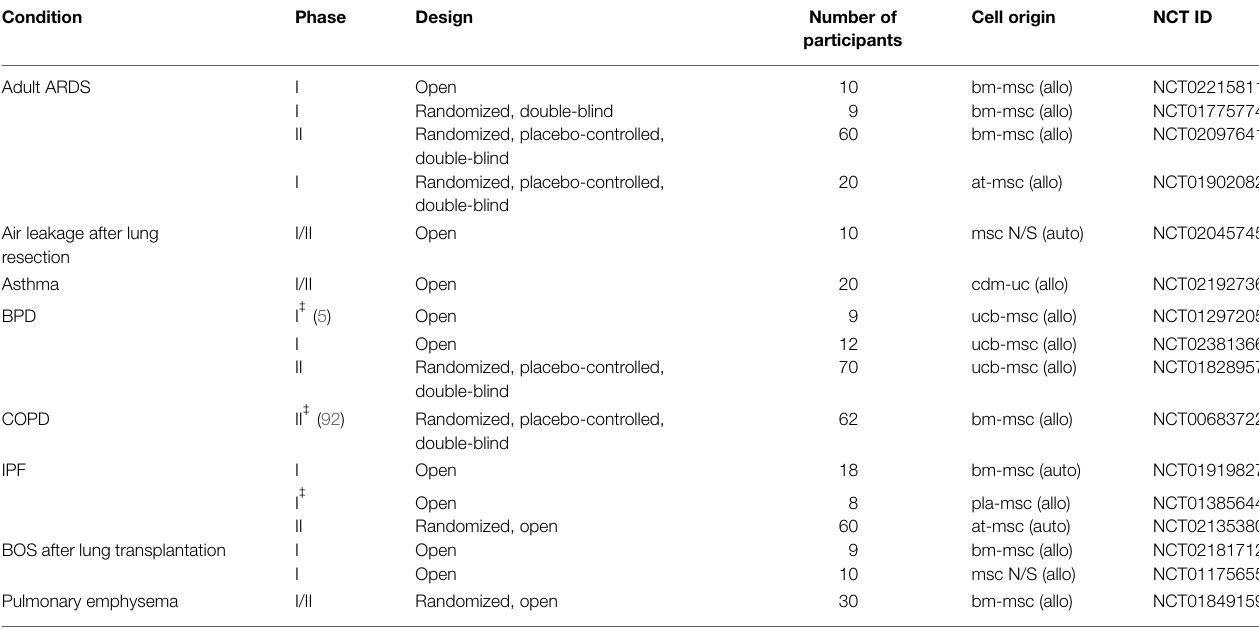
TABLE 1 | MSCs in clinical trails for pulmonary diseases